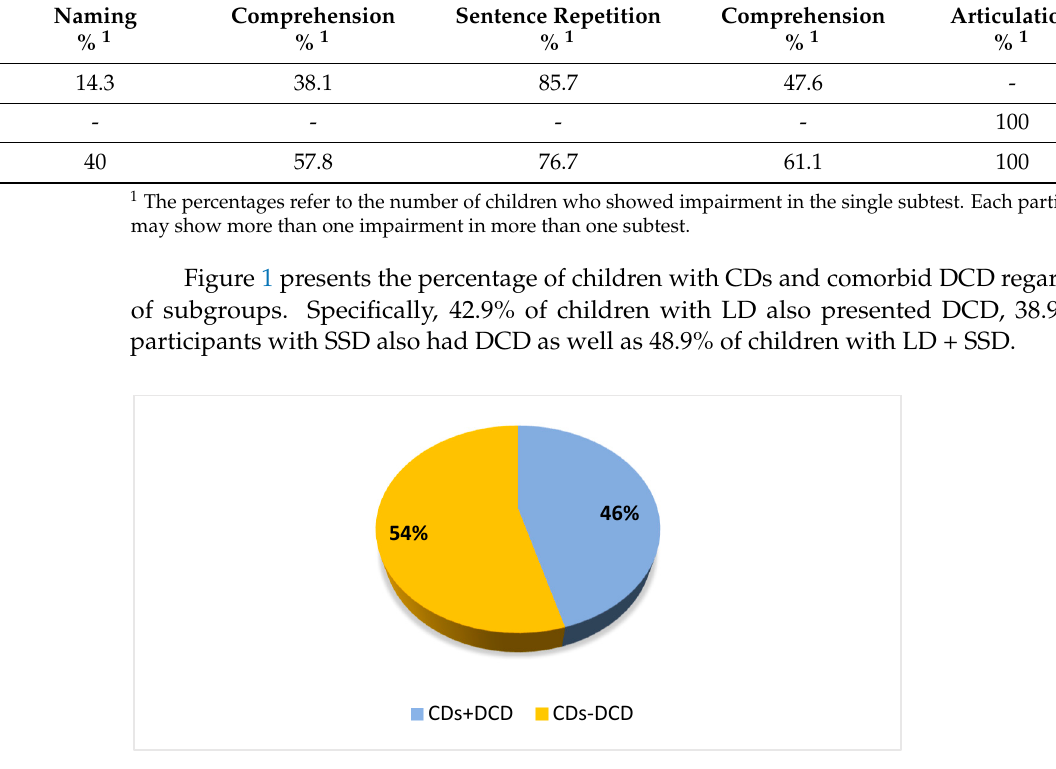
Table 1. Percentages of children with LD, SSD, LD+SSD who obtained clinical scores in Naming, Comprehension, Sentence Repetition, Comprehension, and Articulation subtests (BVL 4–12).